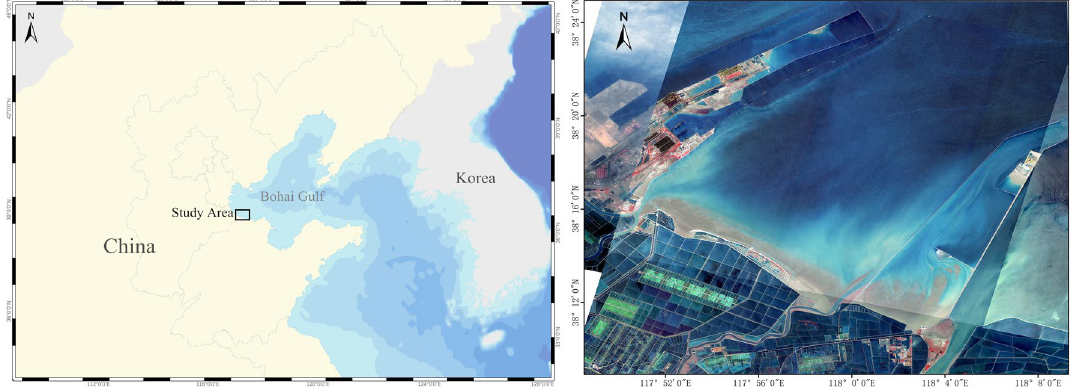
Figure 2. Location and GF2 satellite close-up image of the study area, August 2019 (processed by ArcGIS 10.2 at https ://www.arcgi